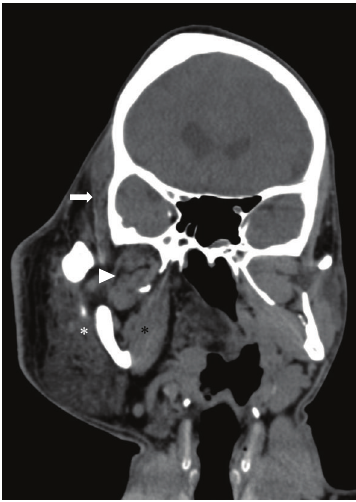
Figure 13: Coronal CT scan revealing hyperplasia of the right mandibular condyle, medial pterygoid (black asterisk), lateral ptery- goid (arrowhead), masseter (white asterisk), and temporalis muscle (white